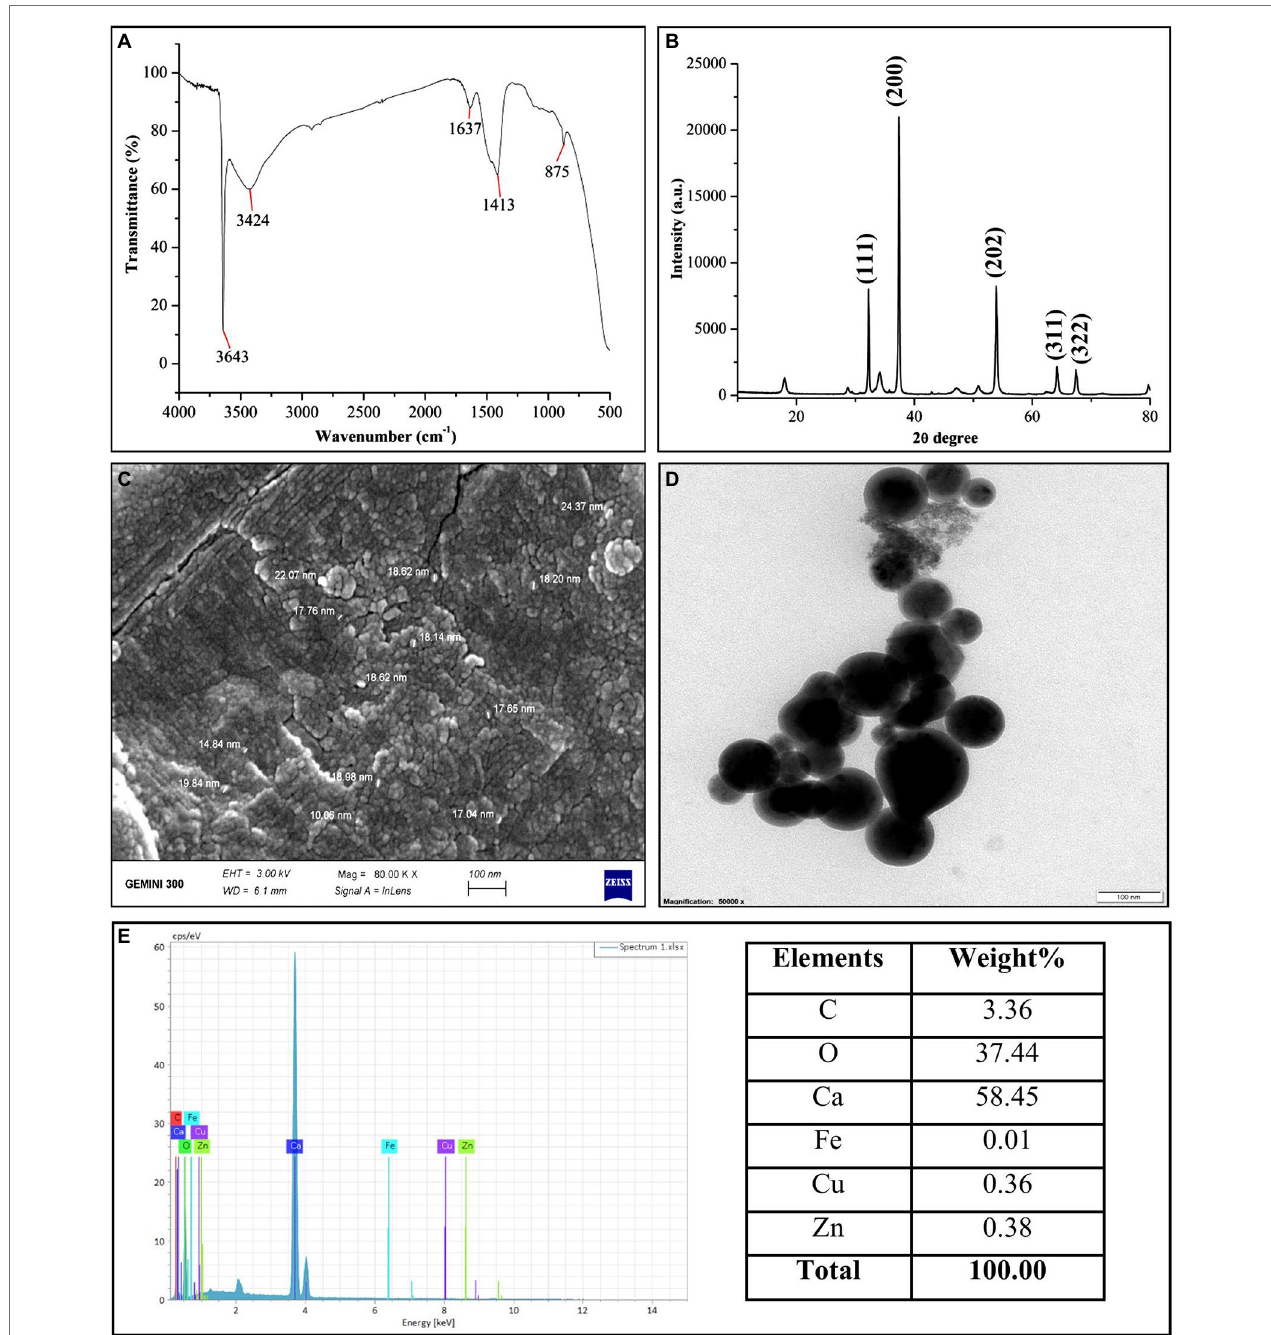
FIGURE 1 | Characterization of CaO NPs. (A) FTIR; (B) XRD; (C) SEM (scale bar = 100 nm); (D) TEM (scale bar = 100 nm); (D)